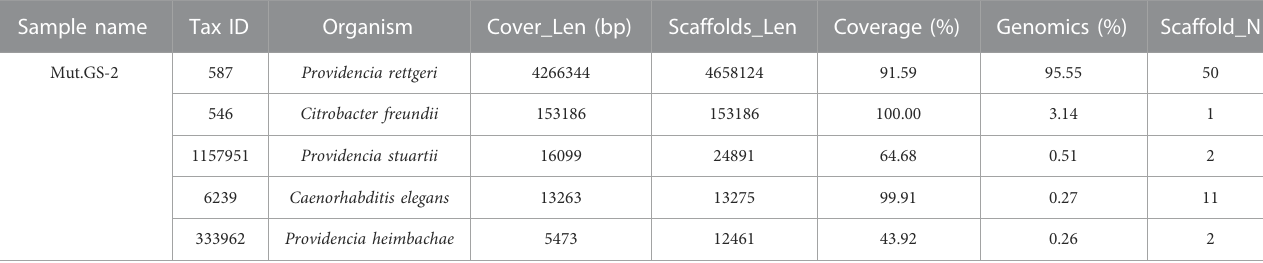
TABLE 2 Bacteria genome sequencing result of Providencia rettgeri